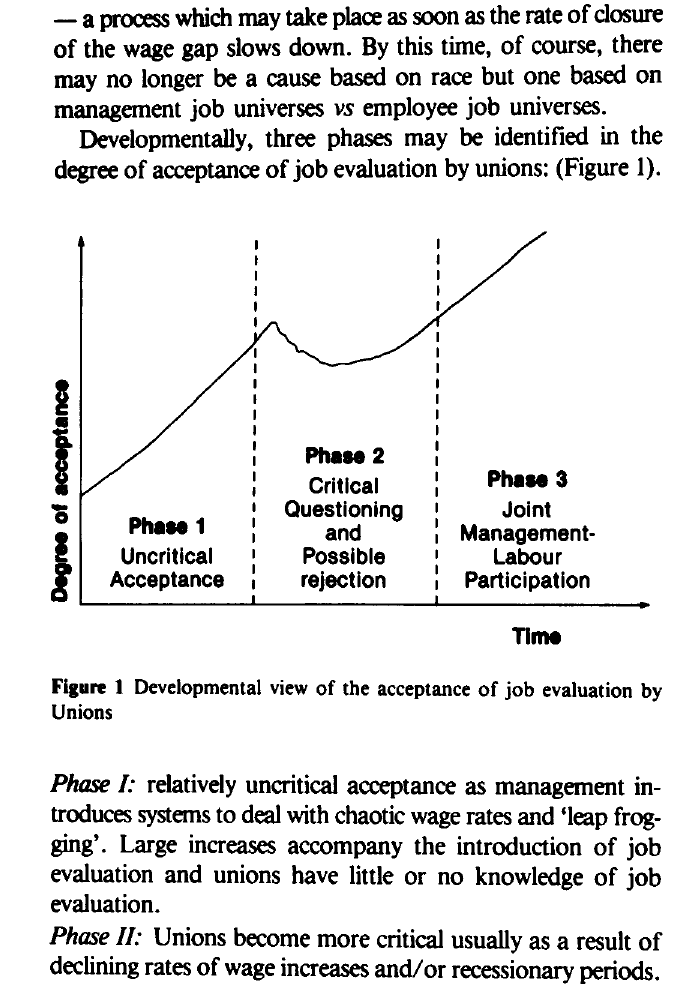
Flgure 1 Developmental view of the acceptance of job evaluation by